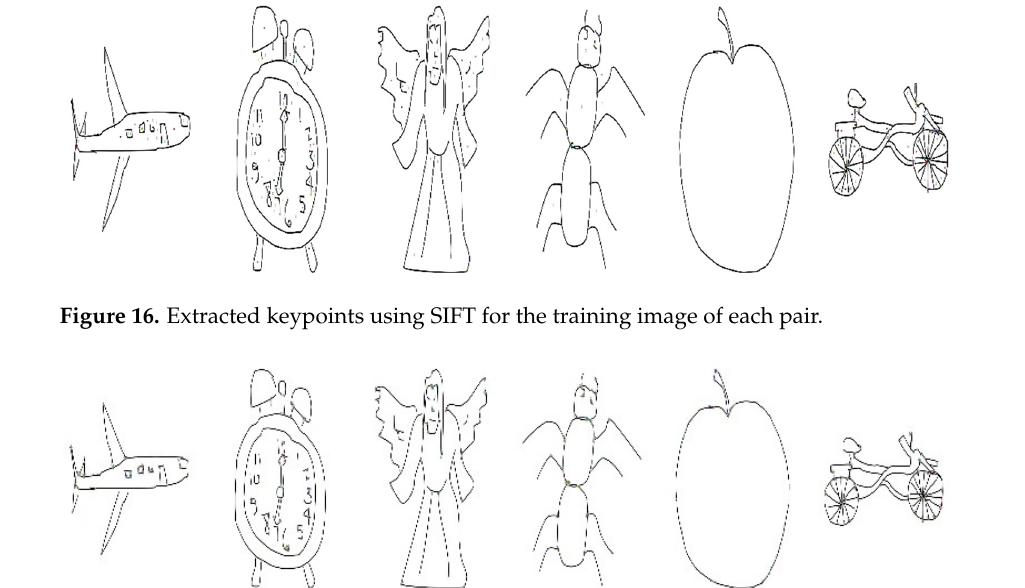
Figure 15. Randomly-selected image pairs from the TU Berlin dataset [43].